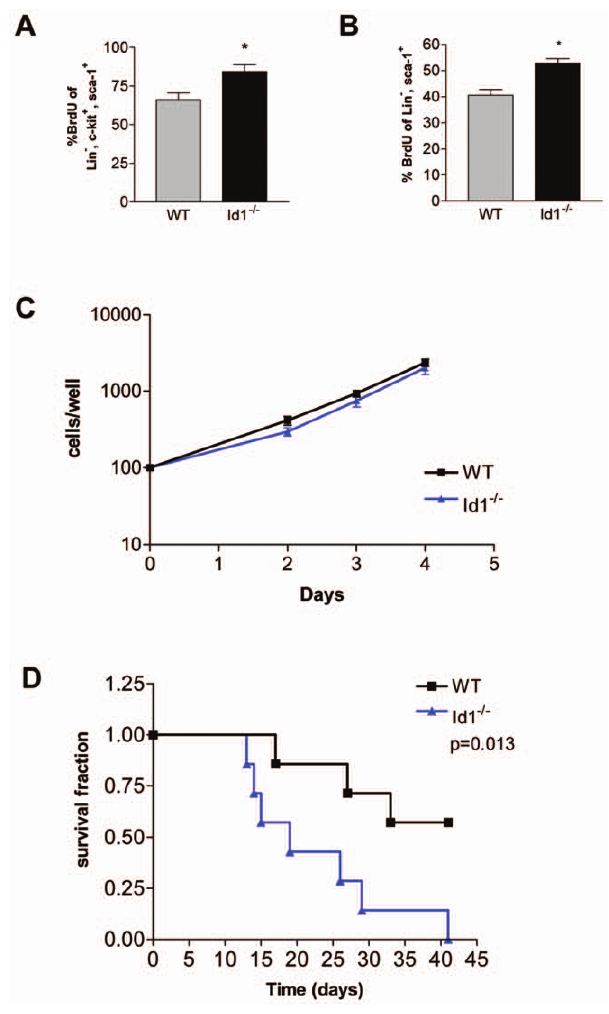
Figure 4. Enhanced proliferation of LSK cells in Id1 2 / 2 mice. (A) In vivo proliferation of LSK cells, at steady state, assessed by flow cytometry for the percentage of BrdU + LSK cells (*P , 0.05; n=5). (B) In vivo proliferation of LSK cells from mice challenged with a single injection of 5-FU. Flow cytometry was performed 15 days post 5-FU to evaluate the percentage of BrdU + LSK cells (*P , 0.05; n=7). (C) In vitro proliferation of sorted LSK cells in response to cytokine stimulation (n=3). (D) Survival over time of wild-type and Id1 2 / 2 mice treated with weekly injections of 5-FU (P=0.013; n=10). Error bars represent 6 S.E.M.